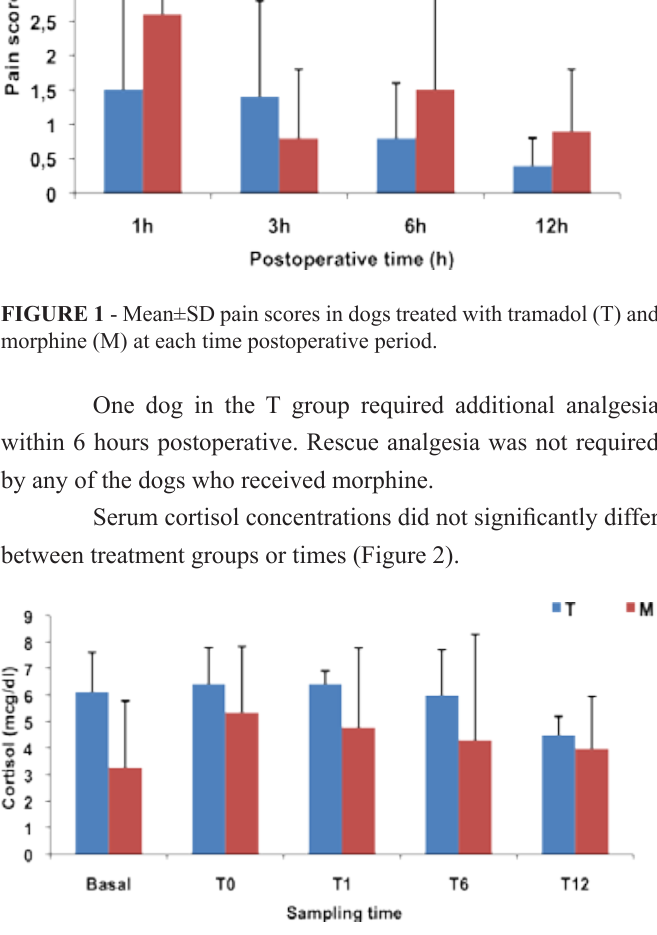
FIGURE 2 - Mean±SD serum cortisol concentration in dogs treated with tramadol (T) and morphine (M) at each time postoperative period. T0, at the time of the ovarian pedicle clamping; T1, 1 hour; T6, 6 hours; T12, 12 hours after tracheal